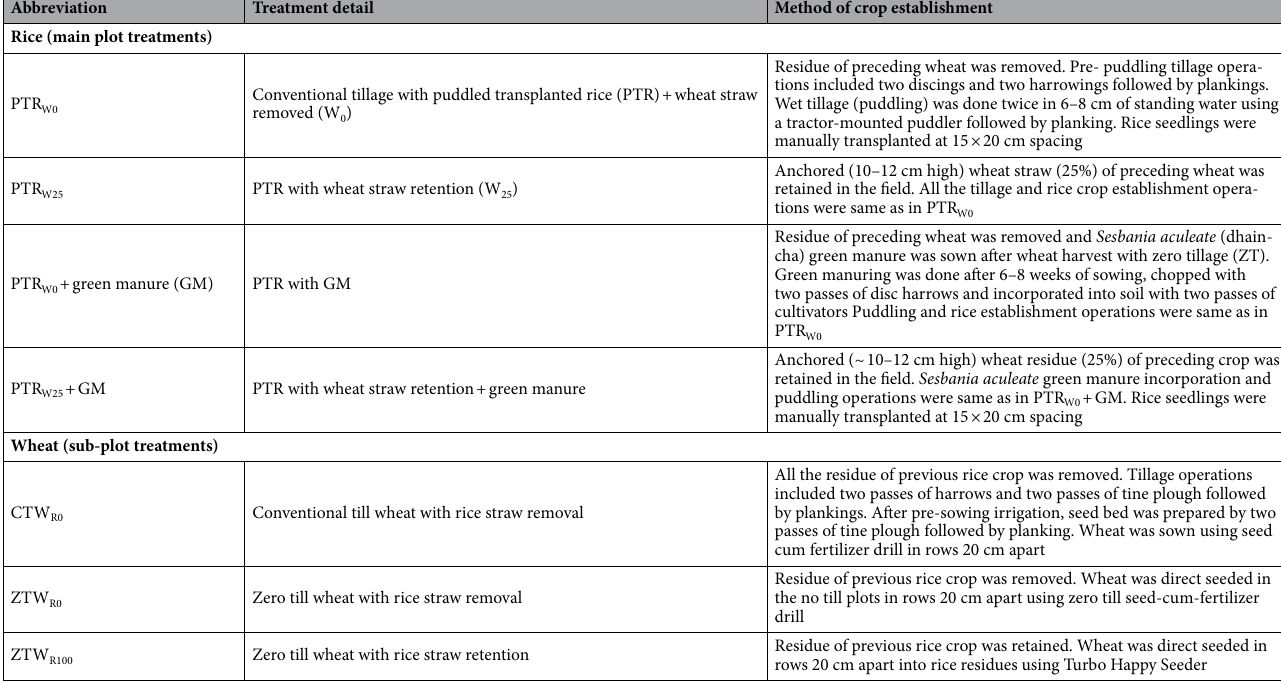
Table 1. Description of